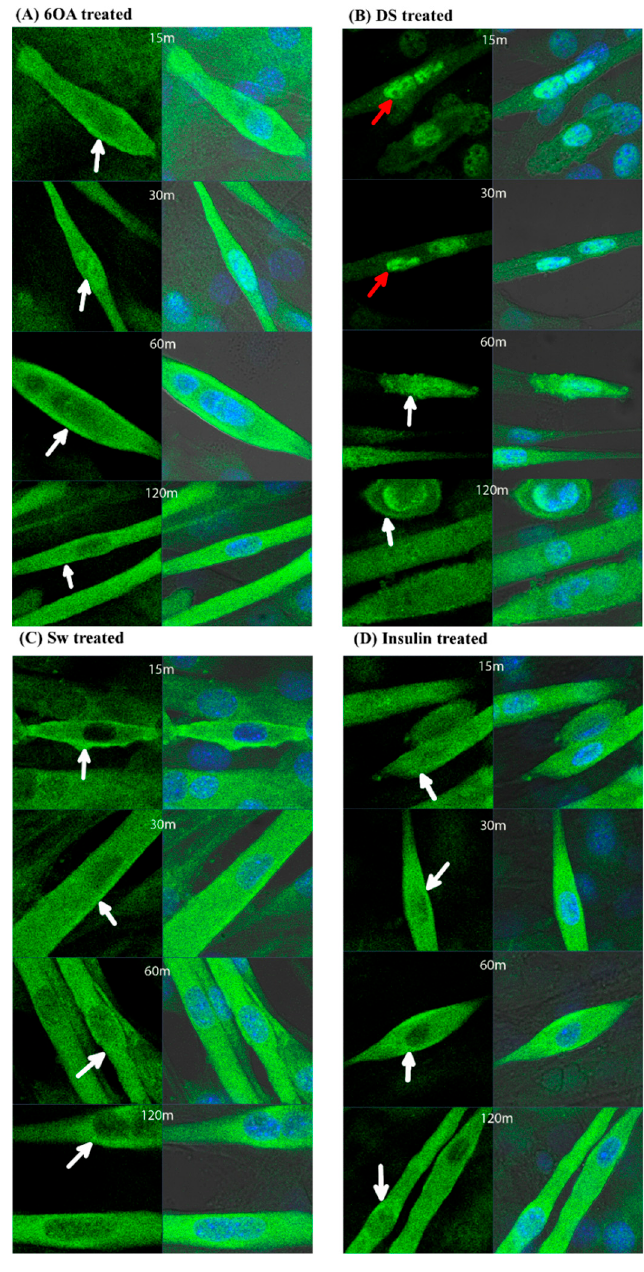
Figure 6. Cont. Figure 6.